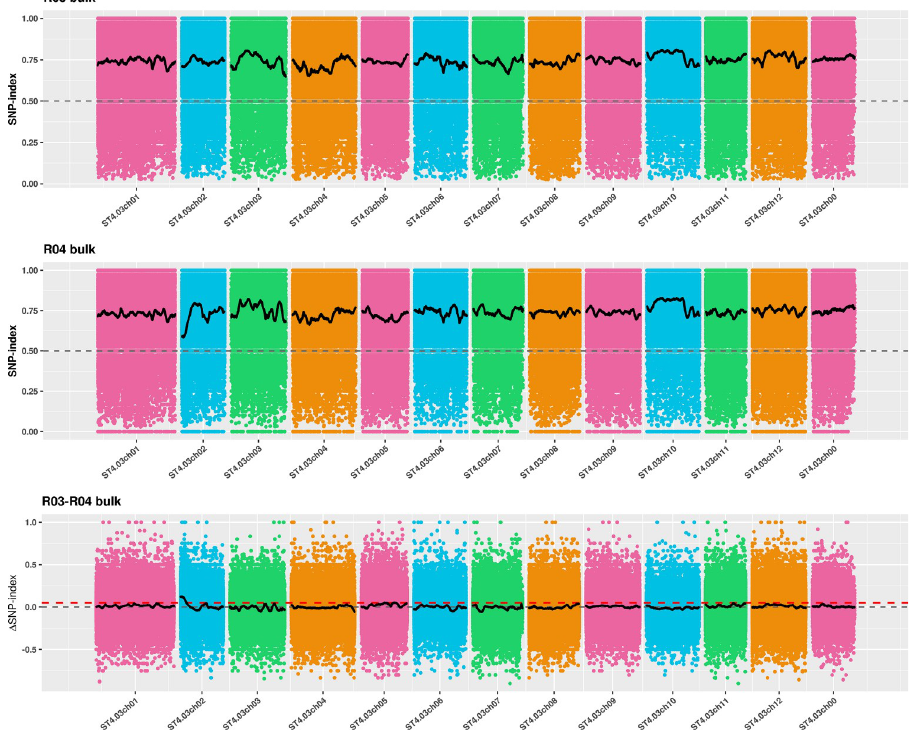
Fig 3. Distribution of SNP-index correlation values on chromosomes. (A) The graph shows the distribution of SNP- index values of the high starch mixing pool. (B) The graph shows the distribution of SNP-index values in the low starch mixing pool. (C) is the distribution of Δ (SNP-index) value. The abscissa is the name of potato chromosome, color dot represents calculated SNP-index (or Δ (SNP-index)), the black line for fitting the SNP-index (or Δ (SNP-index)). The red line represents the threshold line of the 99th